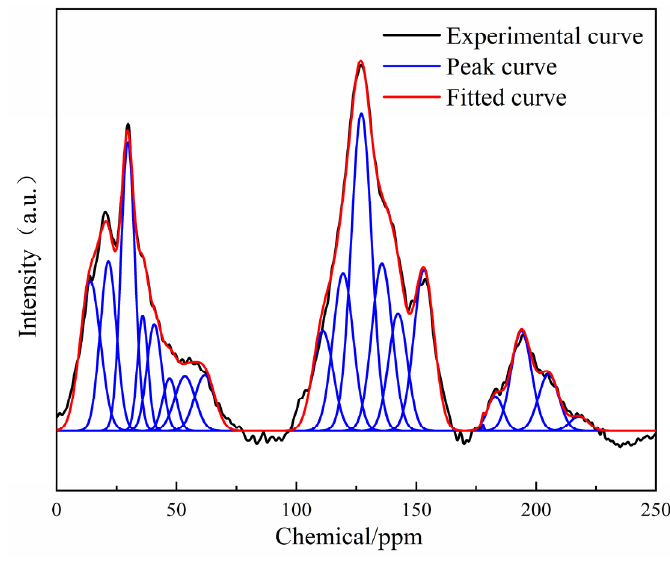
Figure 1. 13 C-NMR spectrum of Kerjian coal.